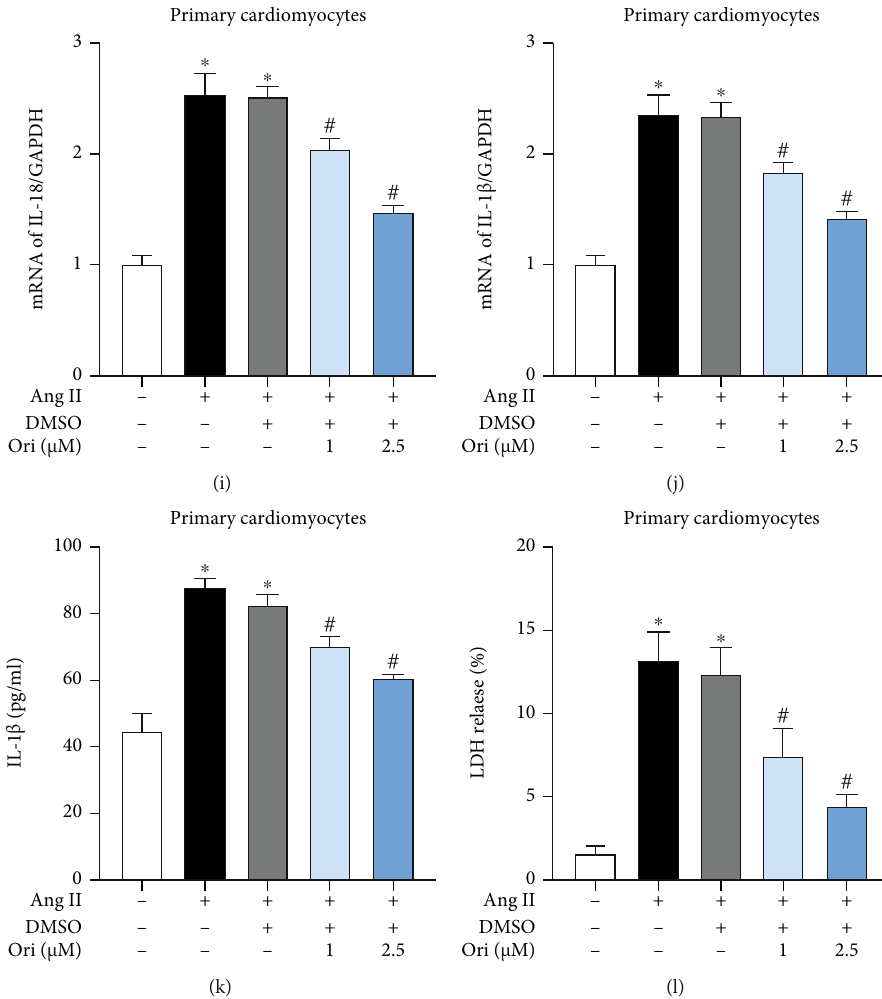
Figure 2: Ang II-induced in fl ammation was inhibited by oridonin. Detection of GSDMD-mediated in fl ammation levels after being incubated with Ang II daylong and pretreated with di ff erent concentrations of Ori for 1h. (a) Gel images of GSDMD and its relevant statistical graph in H9c2 cells. (b) Gel images of NLRP3, IL-1 β , and I-18 and its relevant statistical graph in H9c2 cells. (c, d) The mRNA level of IL-18 in H9c2 cells. (e, f) Contents of IL-1 β and LDH in the supernatant in H9c2 cells. (g) Gel images of GSDMD and its relevant statistical graph in neonatal rat cardiomyocytes. (h) Gel images of GSDMD-related in fl ammation factors and its relevant statistical graph in neonatal rat cardiomyocytes. (i, j) The mRNA level of IL-18 and IL-1 β in neonatal rat cardiomyocytes. (k, l) Contents of IL-1 β and LDH in the supernatant in neonatal rat cardiomyocytes. ∗ p < 0 : 05 compared with control; # p < 0 : 05 compared with Ang